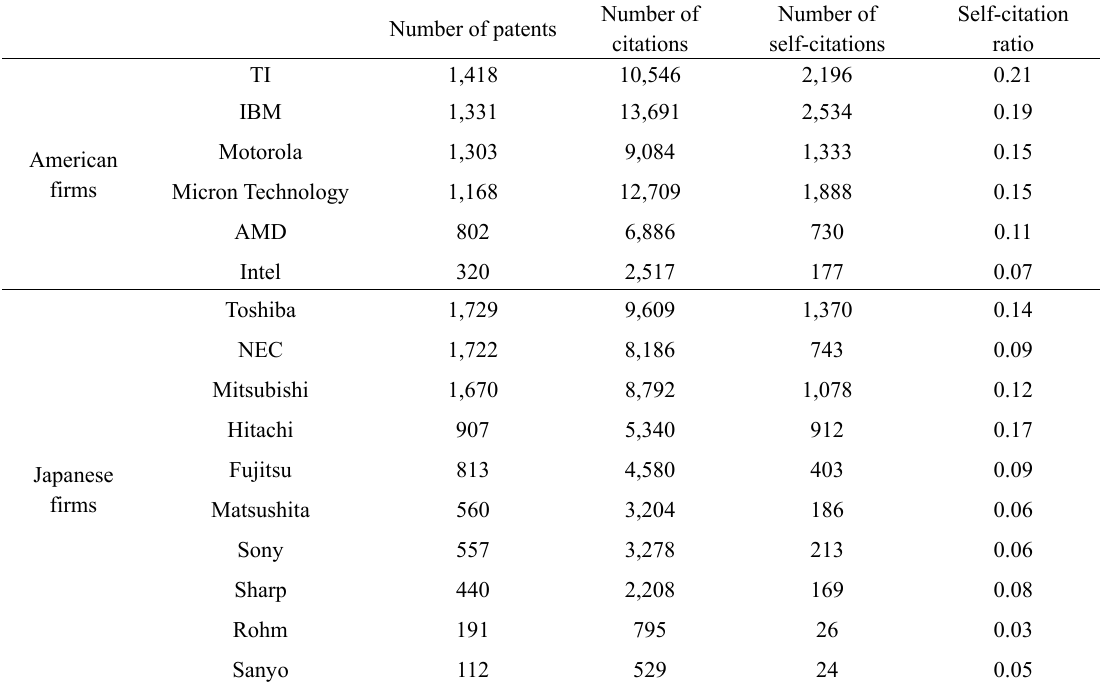
Table 1. Self-citation ratio by